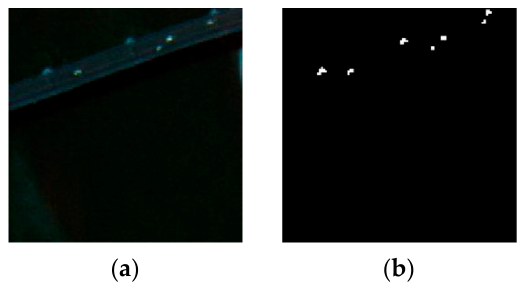
Figure 7. ( a ) Pavia Center dataset; ( b ) Ground truth map.